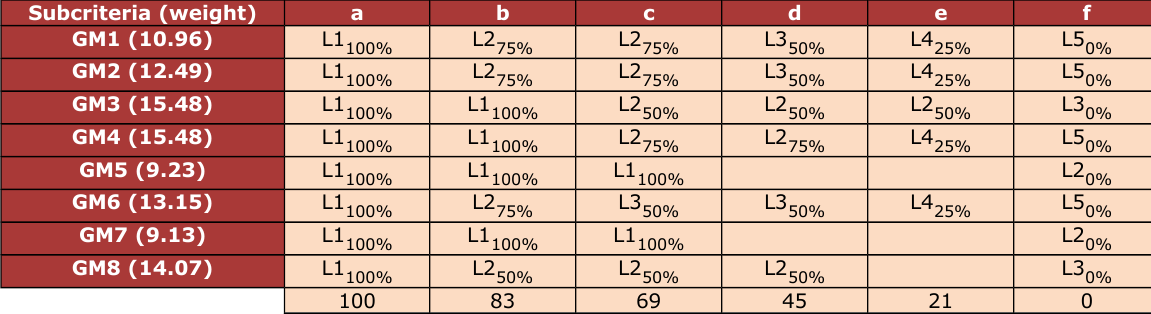
Table 1. Limits between state for green manufacturing